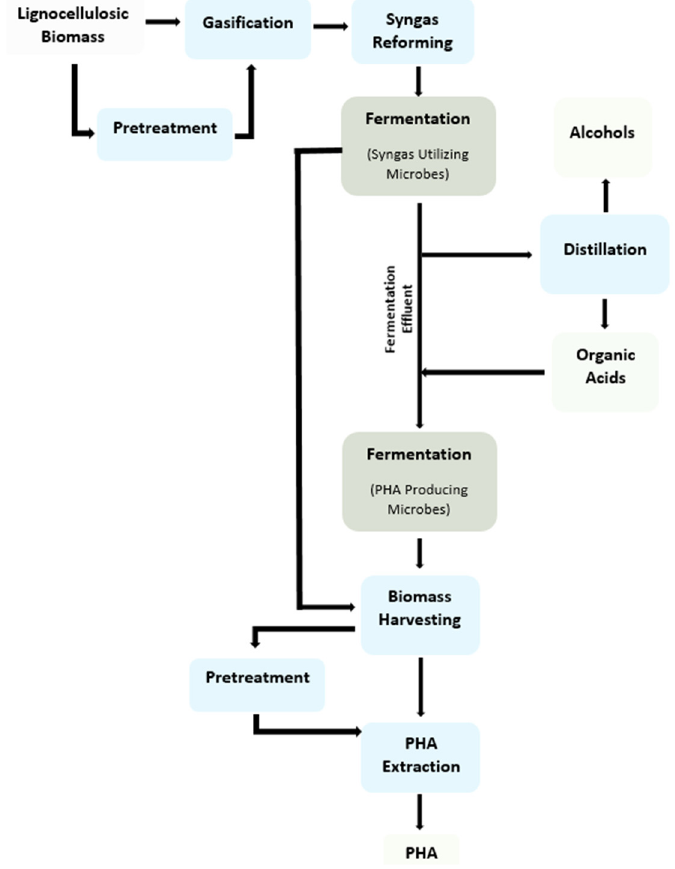
Figure 1. Diagram of the conversion of lignocellulosic feedstock into alcohols, organic acids, and polymers.